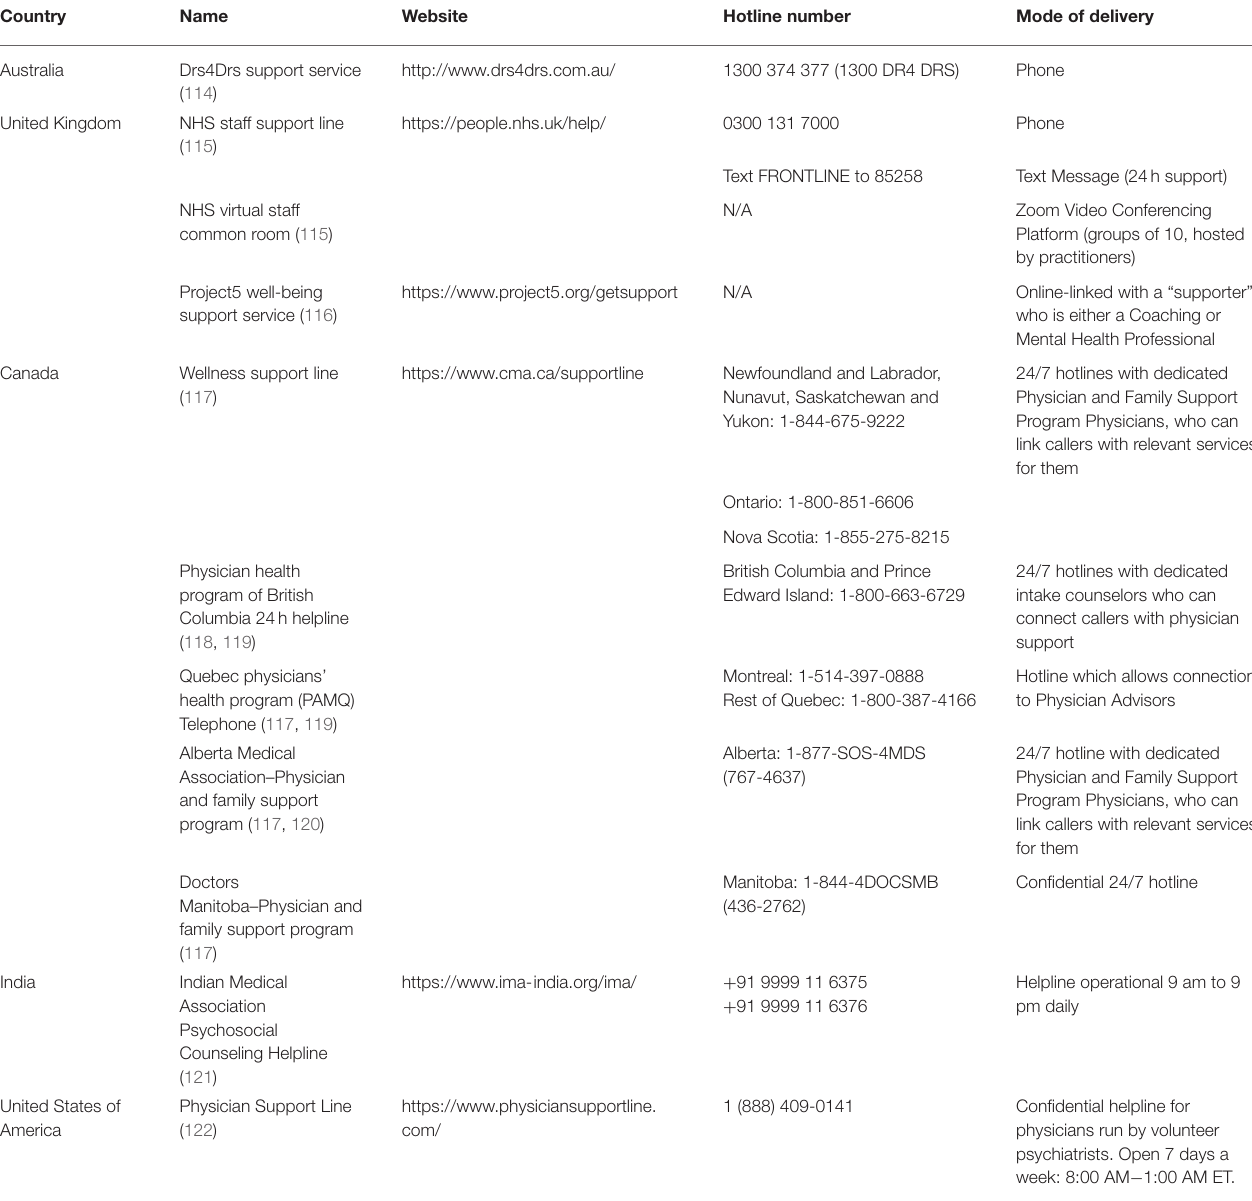
TABLE 3 | Various support services available to doctors and medical students in various countries and regions*.